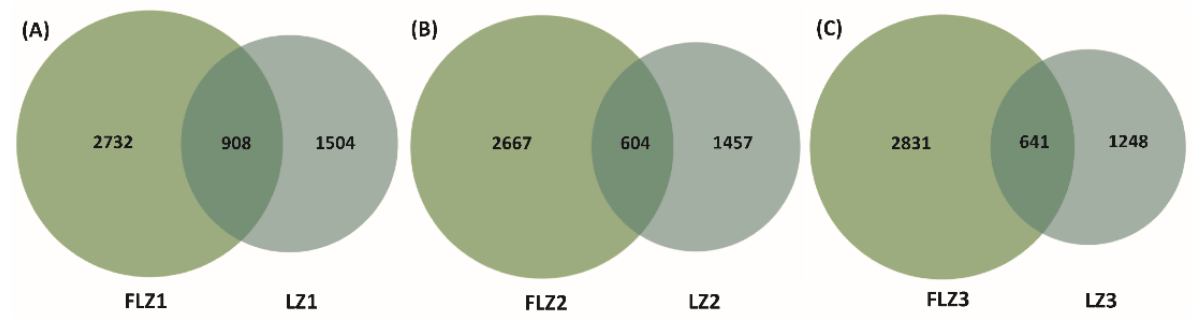
Figure 2. Venn diagram of exclusive and shared species-level taxa among the continuous cropping (LZ) and main cropping (FLZ) soils. ( A ) FLZ1 VS LZ1. ( B ) FLZ2 VS LZ2. ( C ) FLZ3 VS LZ3. LZ1, FLZ1, LZ2, FLZ2, LZ3 and FLZ3 represent the soil samples collected from continuous cropping (LZ) and main cropping (FLZ) at the 4 May (LZ1 and FLZ1), 14 July (LZ2 and FLZ2) and 19 September (LZ3 and FLZ3), 2016.